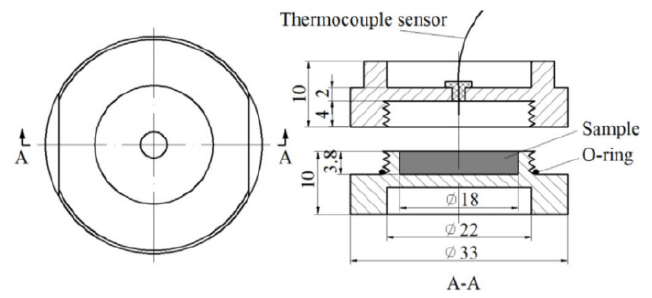
Figure 1. Schematic view of a test cell with 18 mm diameter and 3.8 mm height (All dimensions are in mm) (Adapted from Hou et al. [13]). in mm) (Adapted from Hou et al.